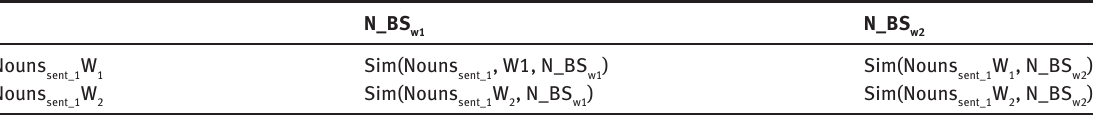
Table 1: Similarity